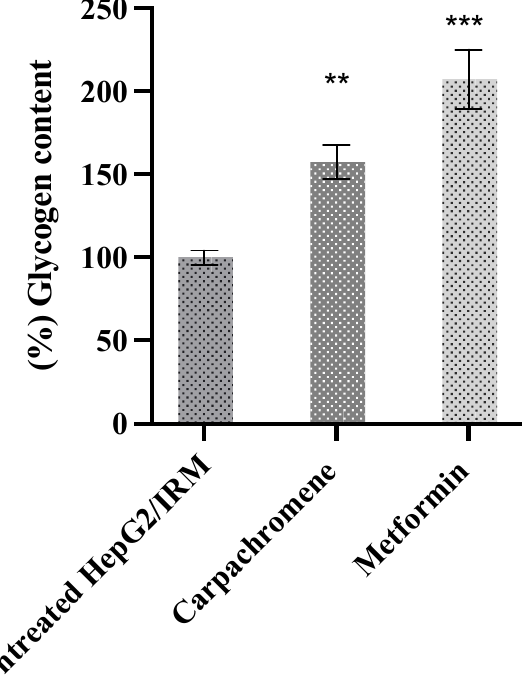
Figure 4. Glycogen content before and after treatment of HepG2/IRM cells with carpachromene or metformin (20 μ g/mL), where untreated HepG2/IRM cells were considered 100%. Bars represent mean ± SD. Significant difference was analyzed by one-way ANOVA test followed by post hoc Dunnett test, where ** p < 0.01, *** p < 0.001, compared to control untreated HepG2/IRM cells.